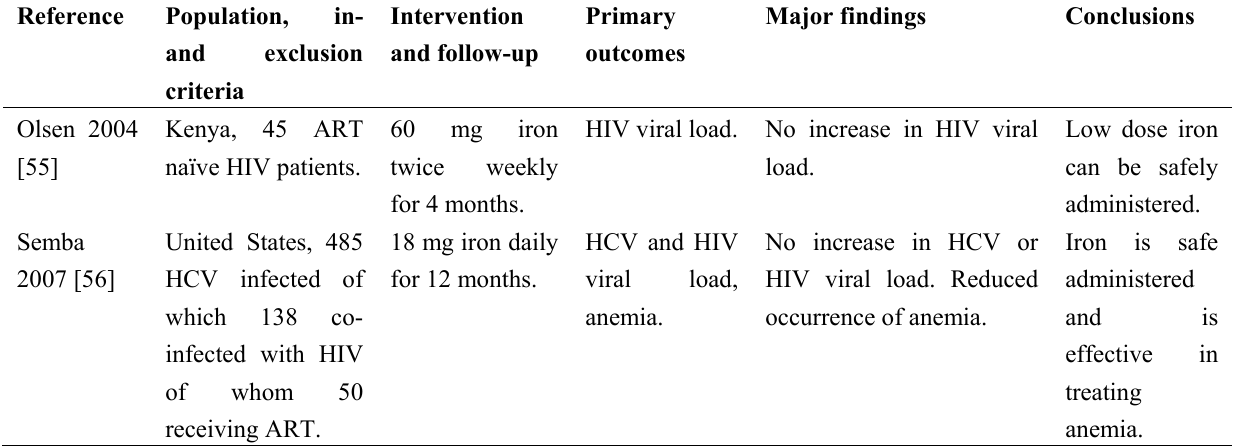
Table 3. Randomized controlled trials on iron supplementation and HIV